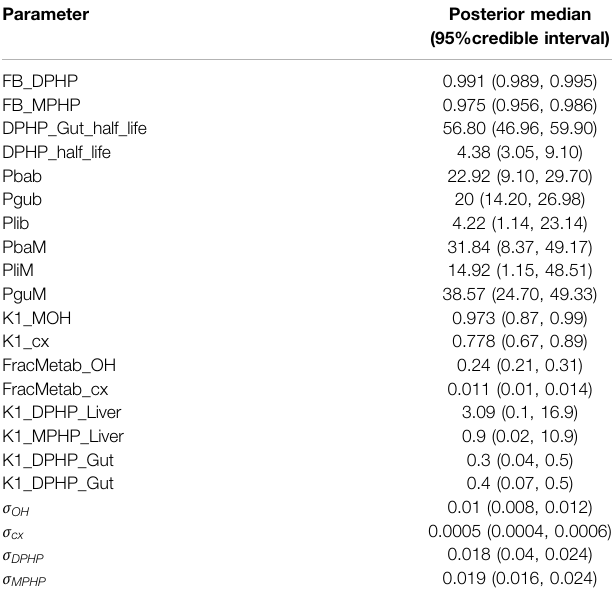
TABLE 4 | Summary statistics from marginal posterior distributions for calibrated global parameters. Parameter